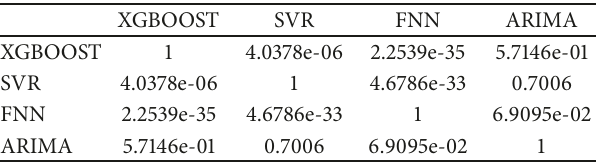
Table 3:Wilcoxon signed rank testbetween XGBOOST, SVR, FNN, and